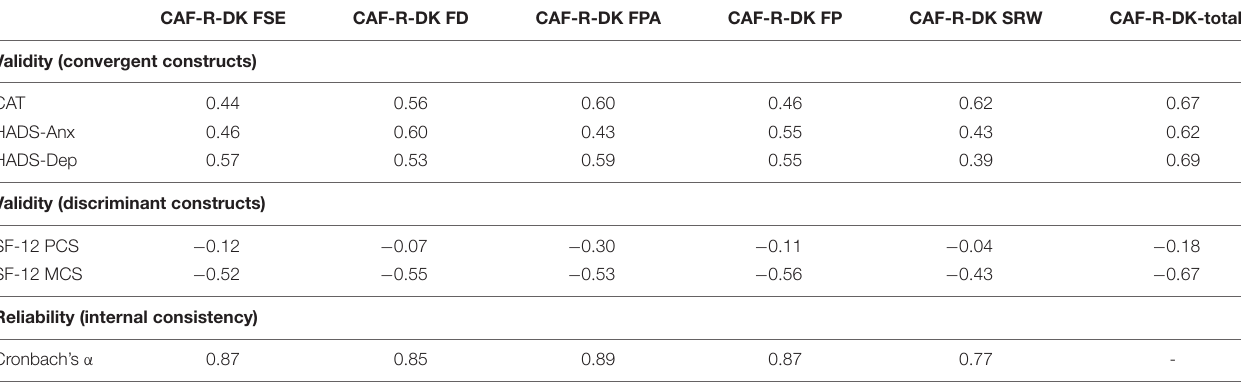
TABLE 2 | Validity and reliability of the chronic obstructive pulmonary disease-anxiety questionnaire revised – Danish version (CAF-R-DK). CAF-R-DK FSE